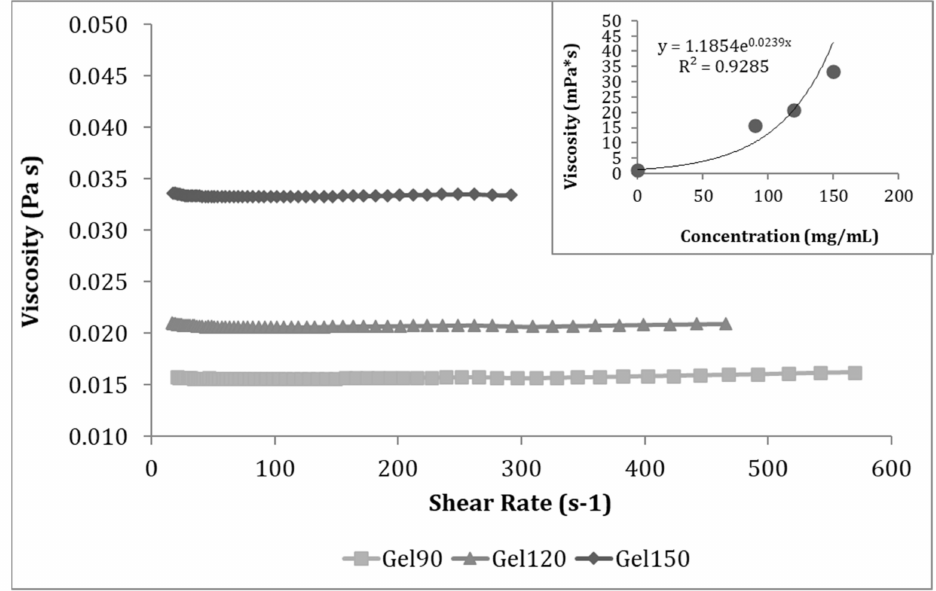
Figure 1. Demonstration of the three different Gel solutions Newtonian behaviour, tested at 45 ◦ C; in the inset is shown the non-linear increase of viscosity with the